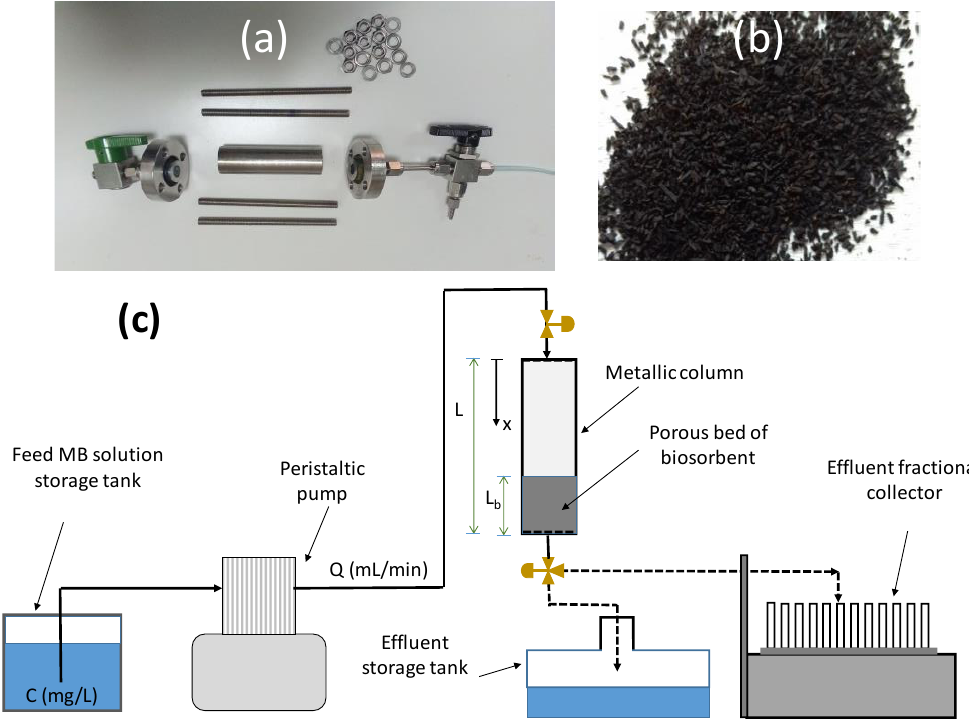
Figure 1. ( a ) Components of the fixed-bed column. ( b ) Packing material. ( c ) Schematic diagram of the experimental setup.